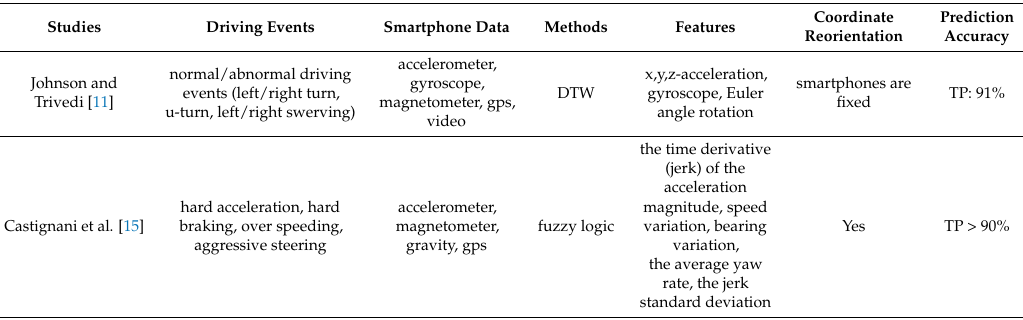
Table 2. Summary of recent researches on driving event